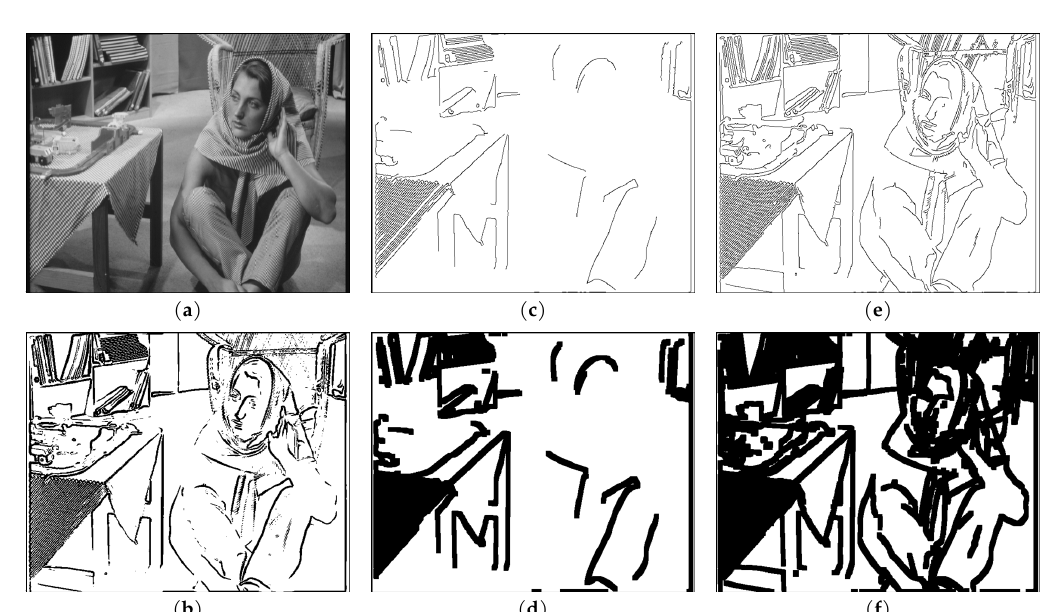
Figure 6. Edges (black) obtained in the proposed and Yang et al.’s JND model: ( a ) original BARB image; ( b ) edges detected by the proposed scheme with default edge-magnitude threshold 11; ( c ) output of original Canny with edge sensitivity threshold 0.5 (default in [11]); ( d ) actual edge regions from Yang et al.’s implementation [22] with threshold 0.5; ( e ) original Canny with edge sensitivity threshold 0.25; and ( f ) actual edge regions from Yang et al.’s implementation [22] with edge sensitivity threshold